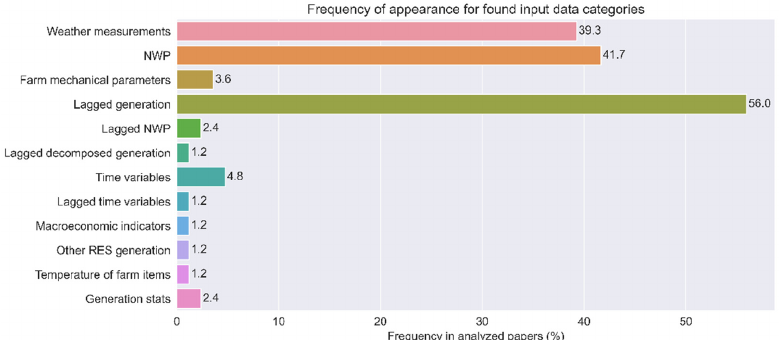
Figure 7. Input data categories by frequency of use.